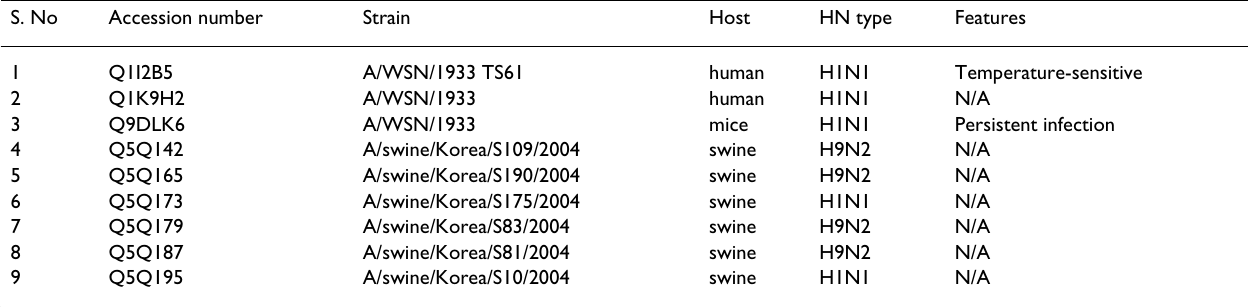
Table 2: Details of the 9 Influenza A virus strains that contain a NP with obpNLS. S.